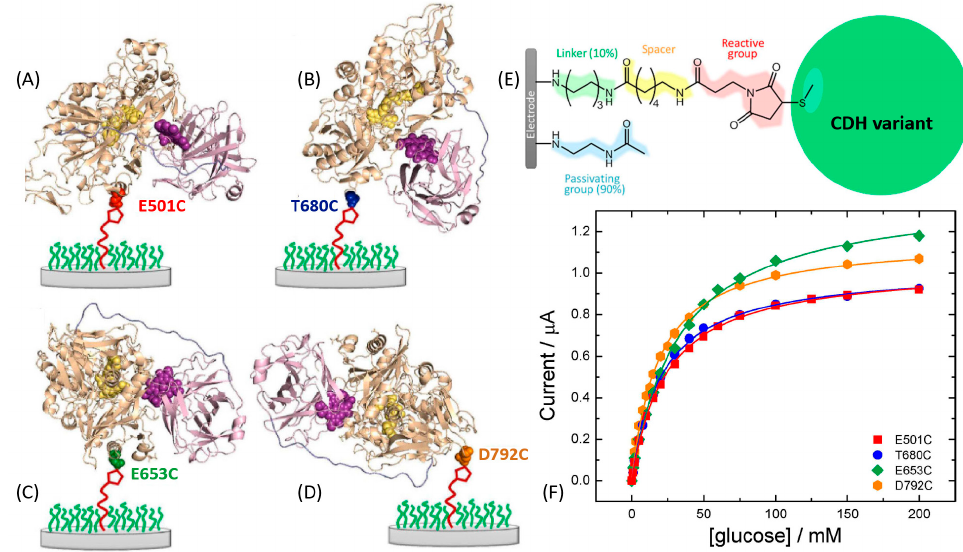
Figure 13. Cartoon representations of the structures of the four different Mt CDH variants attached to the electrode surface in different orientations through the cysteine-maleimide bond. The cytochrome domain is shown in purple and the dehydrogenase domain in pale brown. ( A ) E501C, substrate channel close to electrode (front on); ( B ) T680C, top of enzyme facing electrode (top on); ( C ) E653C, right side of substrate channel facing electrode (right side on); and ( D ) D792C, C-terminus close to electrode (bottom on). The images were obtained with PyMol software based on the crystal structure of Mt CDH, PDB code 4QI6. ( E ) Chemical structure of the whole electrode modification used in this work to immobilize Mt CDH variants with a single surface exposed cysteine, with the different components in different colors. ( F ) Background-corrected catalytic currents at 0.0 V vs. SCE for the four Mt CDH variants from parts (A–D) plotted as a function of the glucose concentration. The definition of all used mutants and their abbreviate names can be found in ref. 167. (The figure was adopted from ref. 167 with permission.).